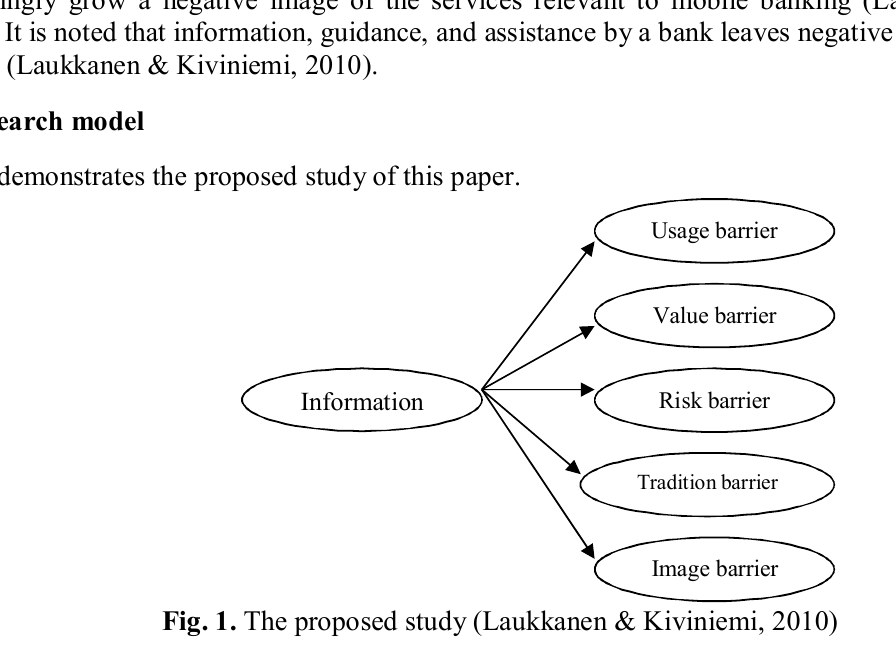
Fig. 1. The proposed study (Laukkanen & Kiviniemi, 2010)